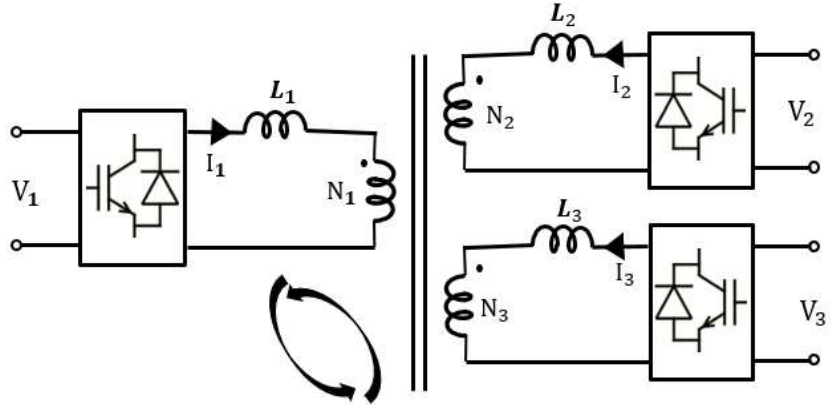
Figure 1. The Triple Active Bridge converter.